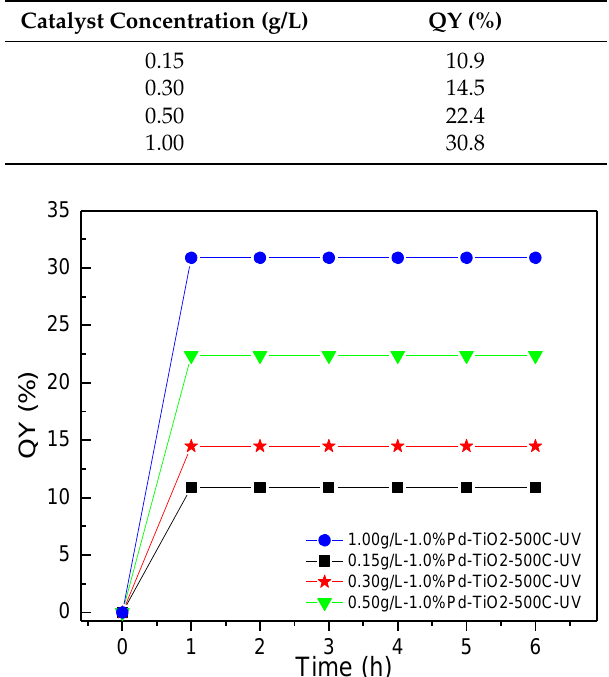
Table 6. Quantum yield for 1.00 wt% Pd–TiO 2 photocatalyst at different photocatalyst concentrations in the slurry.